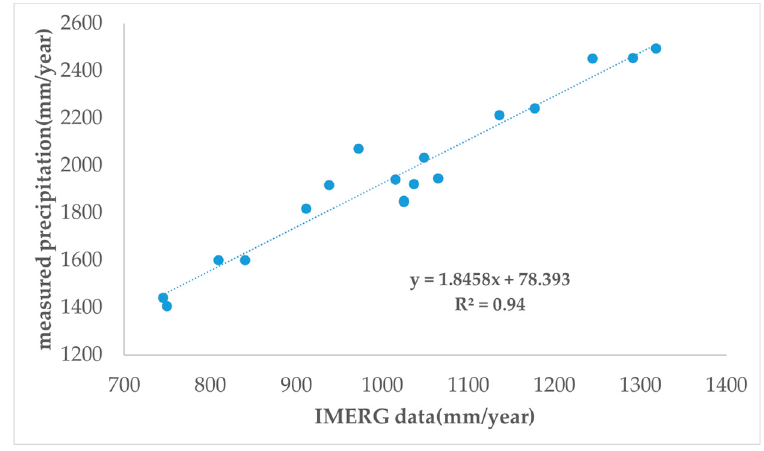
Figure 6. Correlation between observation station measurements and satellite rainfall data.